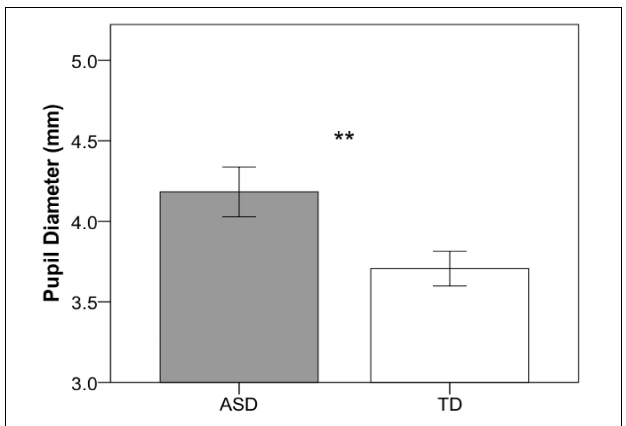
FIGURE 2 | Mean pupil diameter for the resting eye-tracking task for ASD (gray) and TD (white) groups. Error bars represent ± 1 SEM. ** p < 0.05.